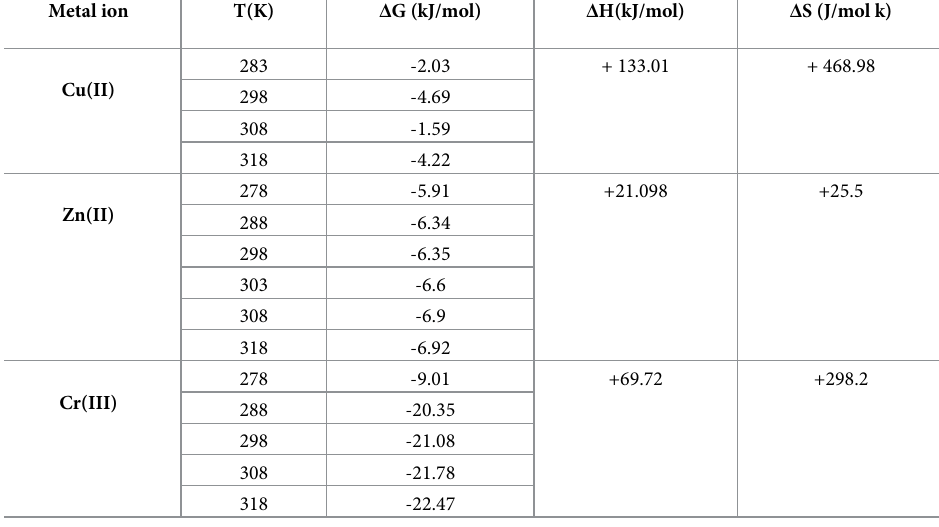
Table 4. Thermodynamic parameters study for the adsorption of Cu(II), Zn(II) and Cr(III) ion adsorption on